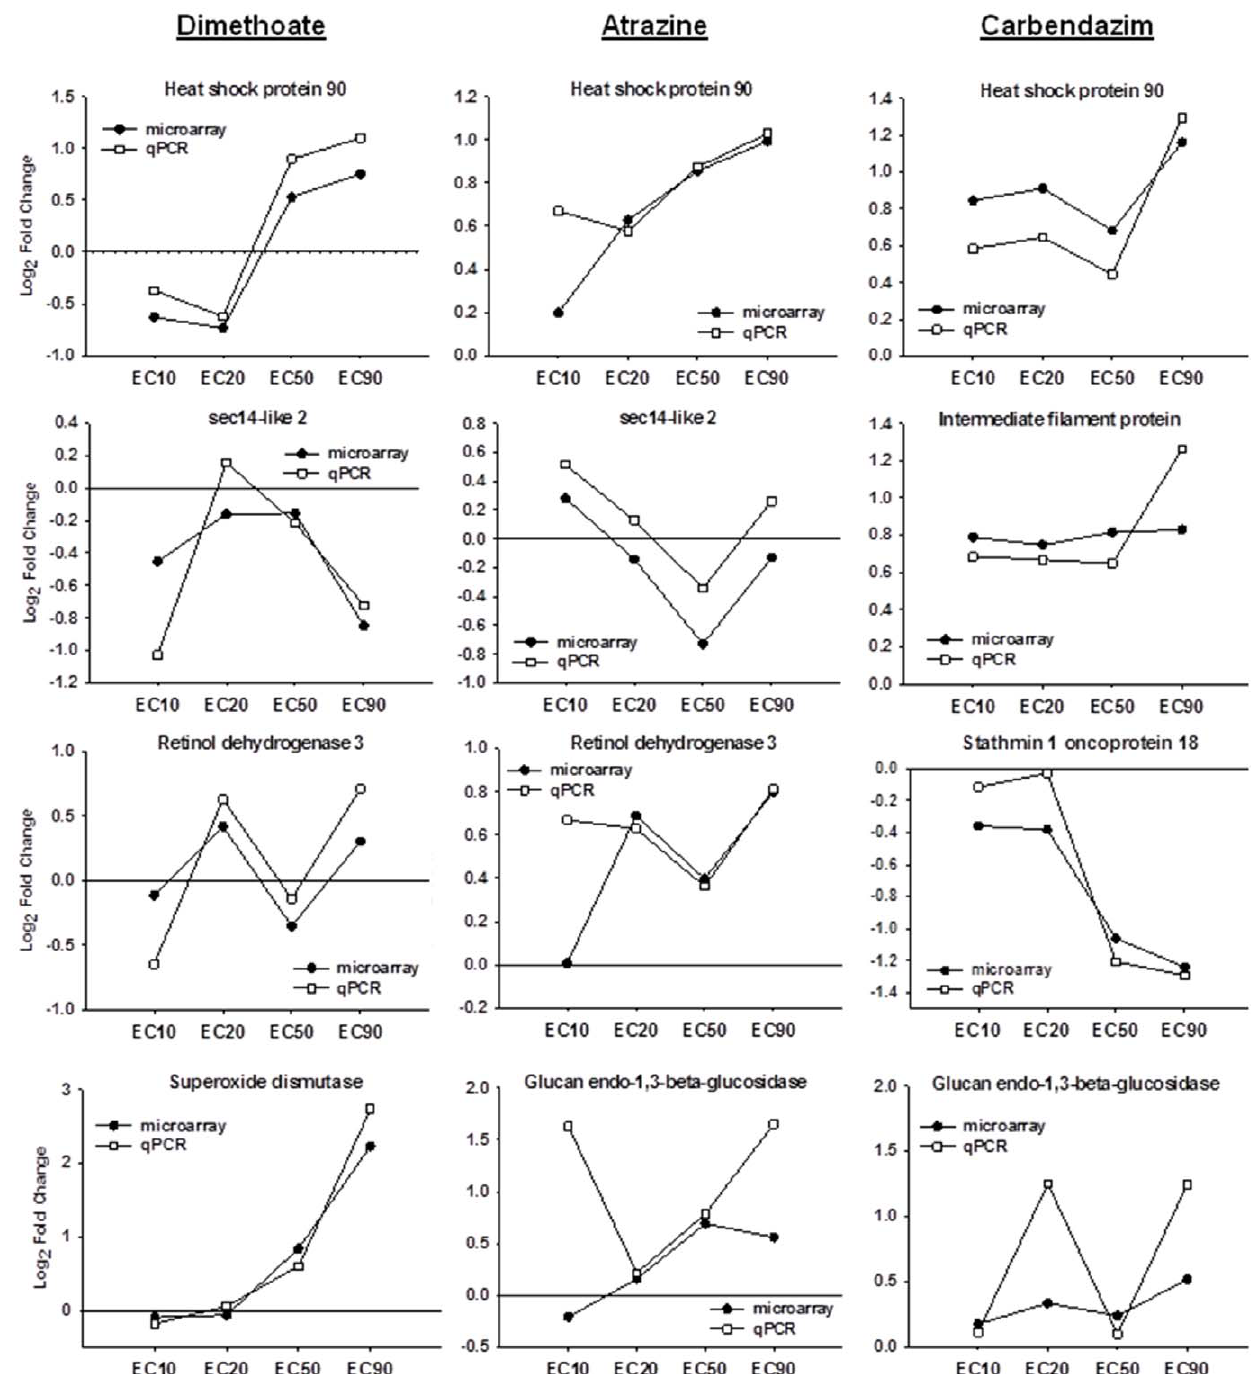
Figure 5. Comparison between microarray and qPCR gene expression analysis. Representation of average log 2 fold change expression values obtained for the genes coding for heat shock protein 90, sec-14 like 2, intermediate filament protein, retinol dehydrogenase 3, stathmin 1 oncoprotein 18, superoxide dismutase and glucan endo-1,3-beta-glucosidase with microarrays (black circles) and qPCR (white squares) after exposure of Enchytraeus albidus to concentrations of dimethoate, atrazine or carbendazim causing 10%, 20%, 50% and 90% reduction in reproduction (EC10, EC20, EC50 and EC90, respectively).